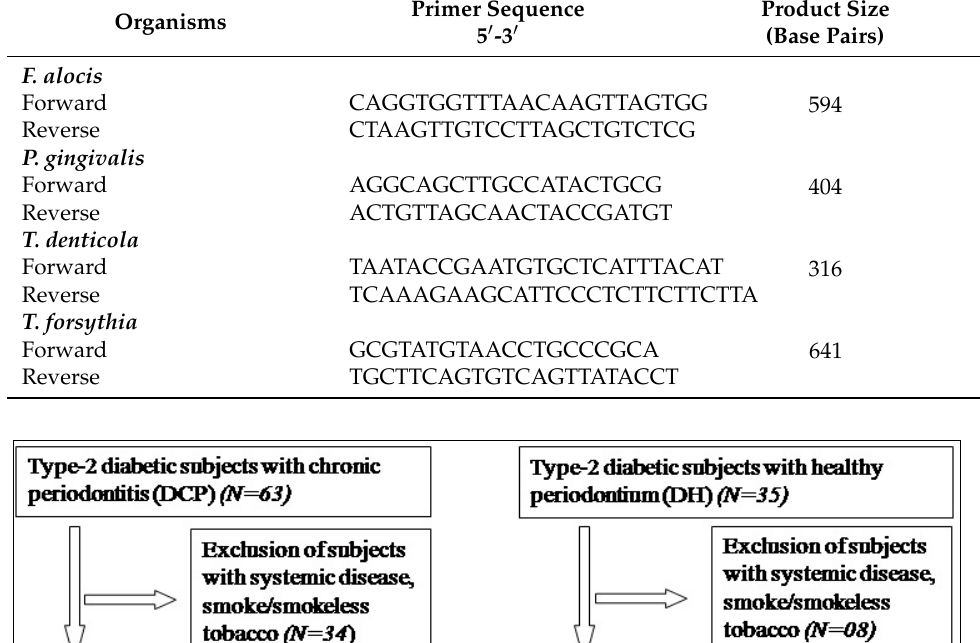
Table 1. Primer sequences used for the DNA amplification of F. alocis and red complex bacteria.